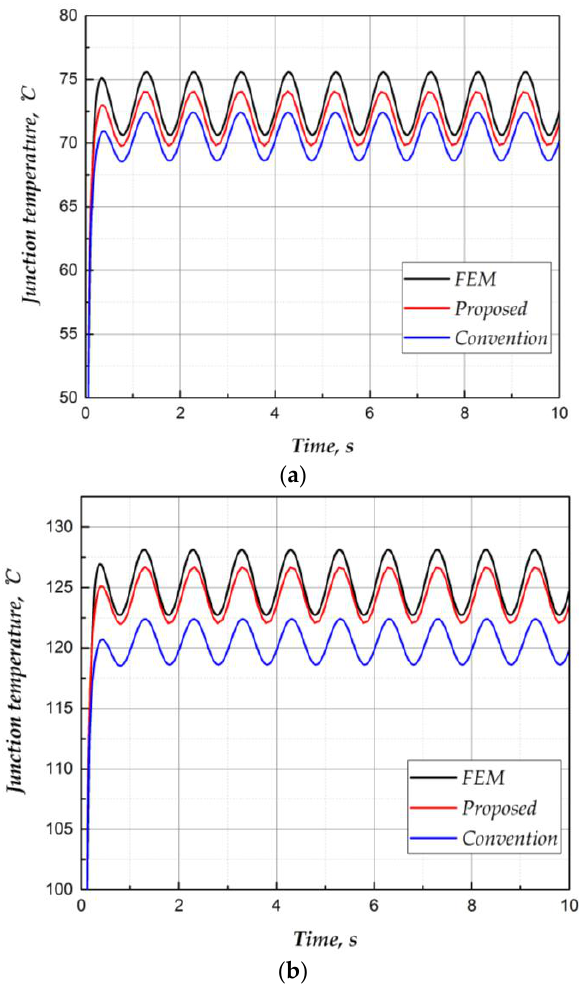
Figure 11. Junction temperature T j as a function of time for the SKM75GB12T4 module during the variable heat flow test estimated from two thermal models: ( a ) the ambient temperature is 50 °C; ( b ) the ambient temperature is 100 °C.